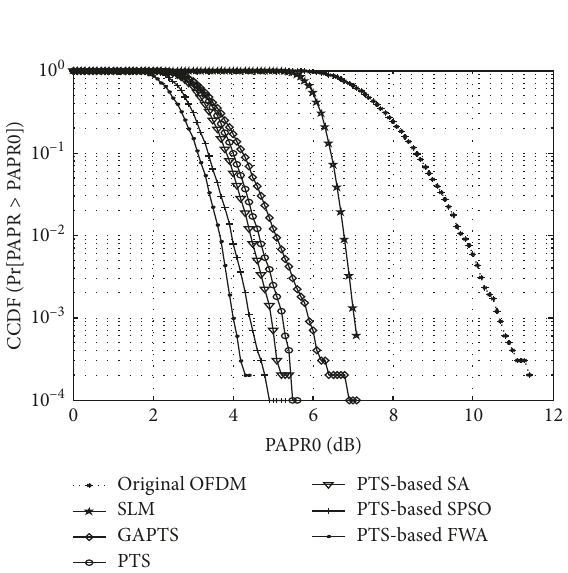
Figure 2: CCDFs comparison with different searching algorithms and conventional PTS.